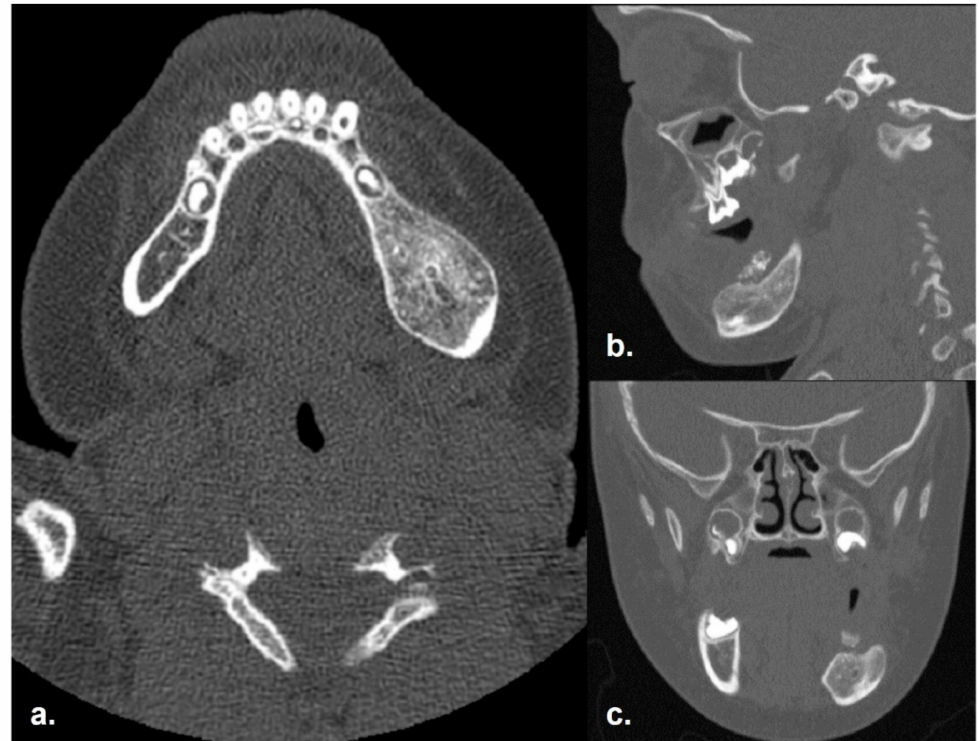
Figure 8. Postoperative non-contrast facial computed tomography (CT) performed 5 months after surgery. In the axial view ( a ), the asymmetry of the left mandibular body due to the exuberant bone regeneration is evident, but any bone defect is no more detectable. ( b ) Sagittal view; ( c ) coronal view.